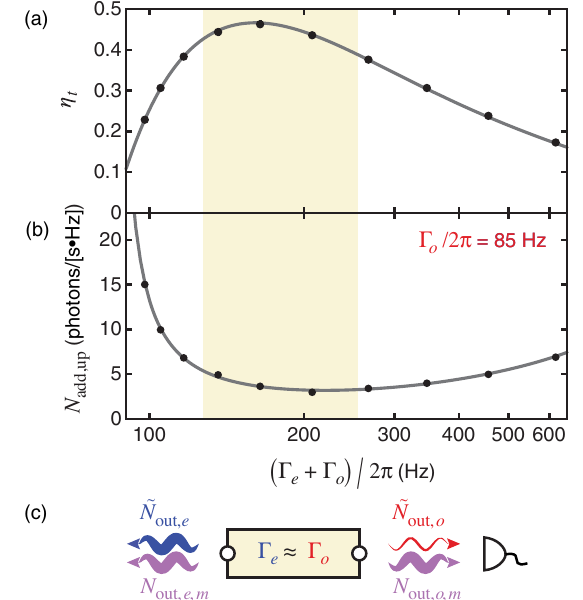
FIG. 3. Minimizing input-referred added noise. (a) Transducer Γ efficiency η versus Γ , sweeping electromechanical damp- t e þ o = 2 π ¼ 85 Hz, with ing Γ at fixed optomechanical damping Γ e o Γ fit. (b) Upconversion added noise N versus Γ at e þ o add ; up Γ = 2 π ¼ 85 Hz, with fit. (c) Schematic representation of trans- o ≈ Γ ducer output noise in the Γ regime shaded yellow in (a) and e o (b), where the box represents the transducer, wavy arrows represent contributions to the microwave and optical output noise near mechanical resonance, and the photodetector indicates optical readout, as in Fig. 2(e). Error bars representing one standard deviation are smaller than the size of the